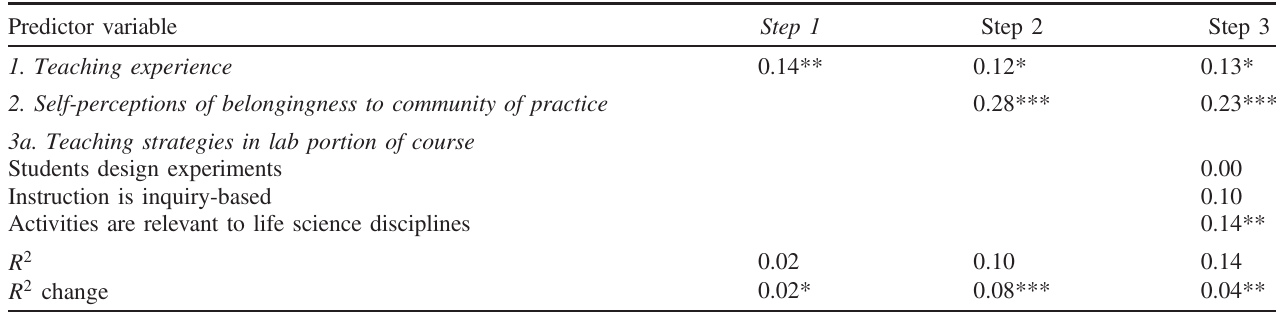
TABLE II. Summary of hierarchical regression analyses predicting perceived course effectiveness from teaching experience, self- perceptions of belongingness to community of practice, and teaching strategies in lab portion of